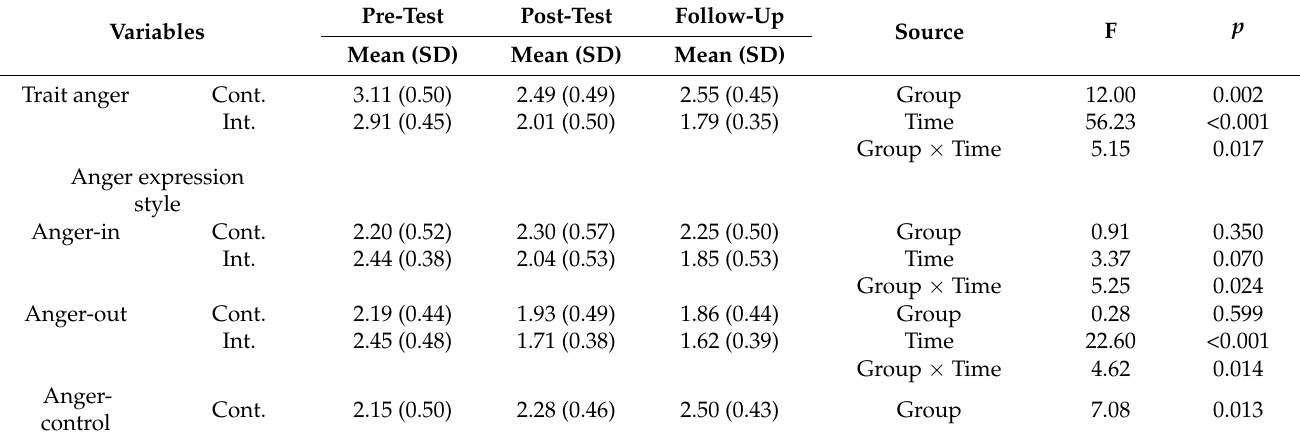
Table 4. Comparison of changes in trait anger, anger expression style, grateful disposition, and depression levels between control and intervention